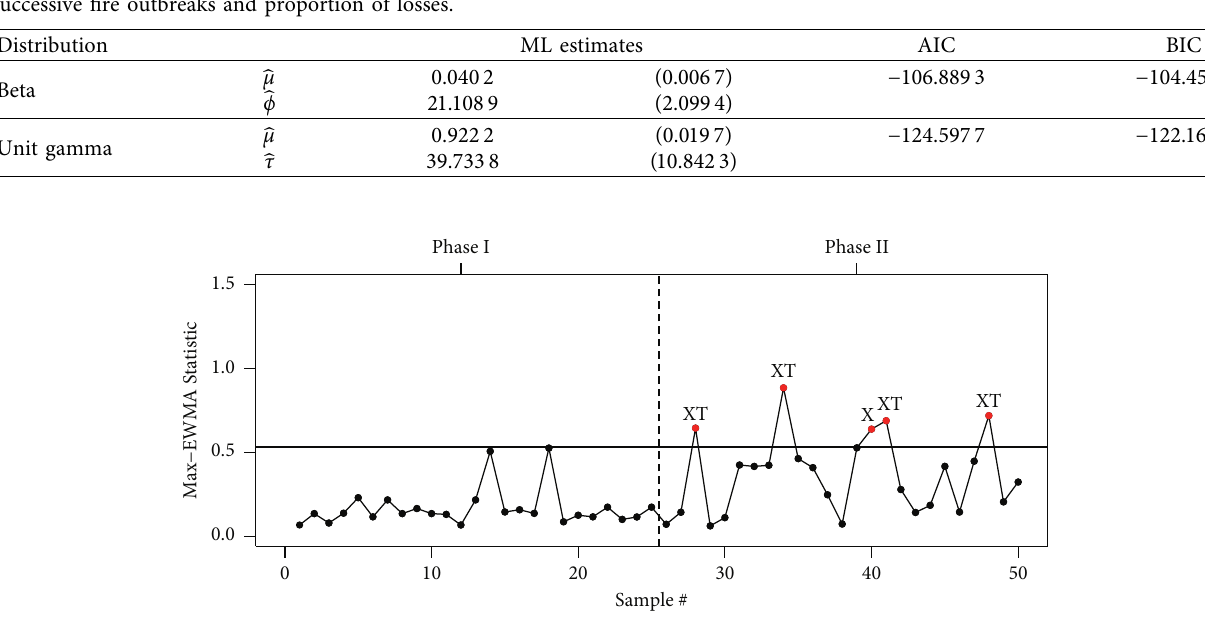
Figure 1: Max-EWMA chart for monitoring the fire outbreaks considering simultaneous shift in shape 1 parameter of beta distribution and shape parameter of unit gamma distribution.